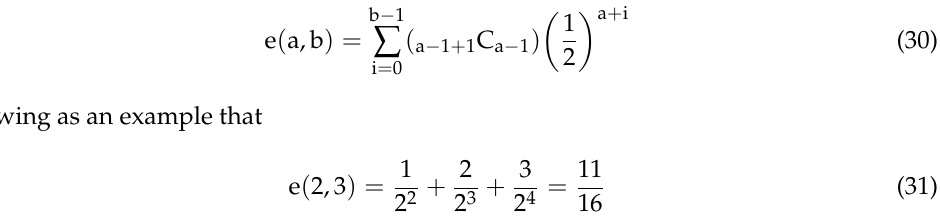
and the probability of (cid:2872)(cid:2870) 42